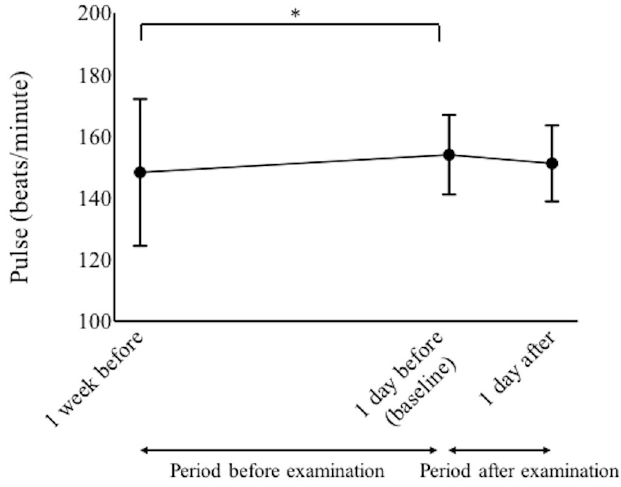
Fig 5. Pulse rates from 1 week before examination to 1 day after examination. � Statistical difference (p < 0.05, paired-t tests with Bonferroni correction).